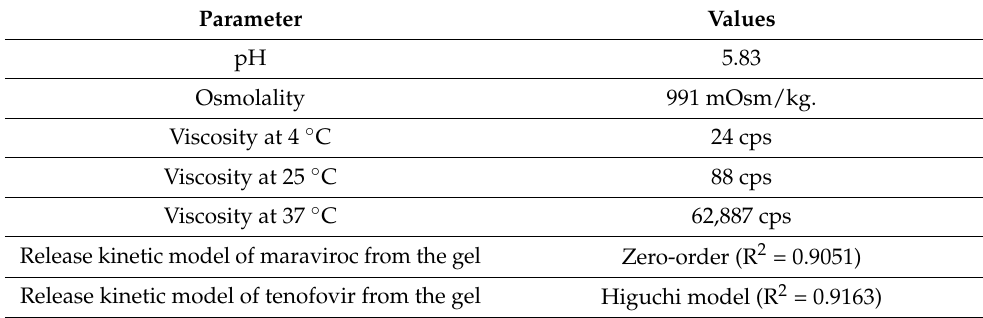
Table 4. Characterization for thermosensitive gel containing maraviroc and tenofovir micro- spheres.